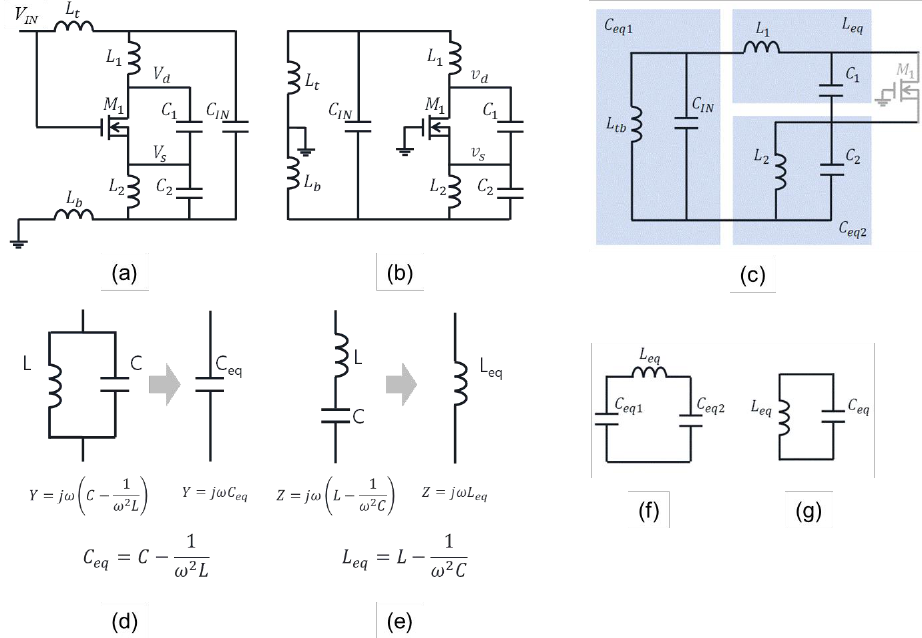
Figure 6. Circuit reduction of mESCO from ( a ) through ( g ); ( a ) original mESCO, ( b ) small-signal equivalent circuit of ( a ), ( c ) omitting M1, ( d ) equivalent capacitance of L and C connected in parallel, ( e ) equivalent inductance of L and C connected in series, ( f ) circuit reduced from ( c ) with ( d ) and ( e ), and ( g ) circuit reduced from ( f ).